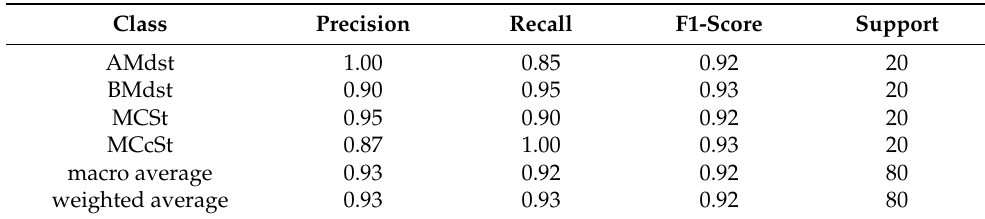
Table A7. Classification report for ResNet18 pretrained on RawFooT. The overall accuracy is 0.93.